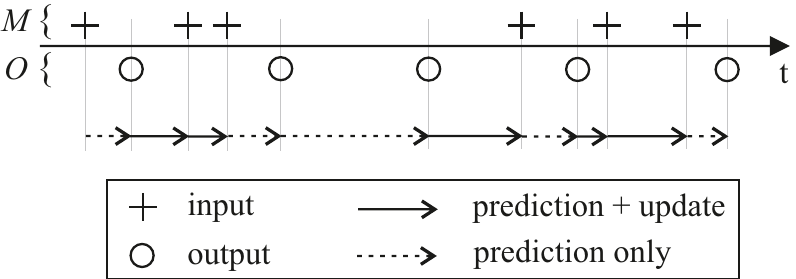
Figure 2. The sample rate conversion scheme uses the prediction abilities of the